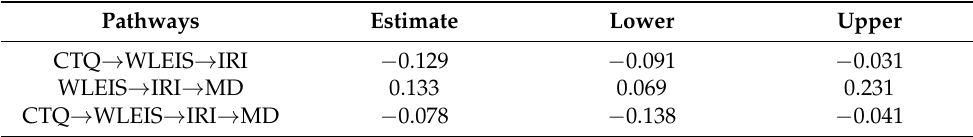
Table 3. Standardized indirect effects and 95% confidence intervals.